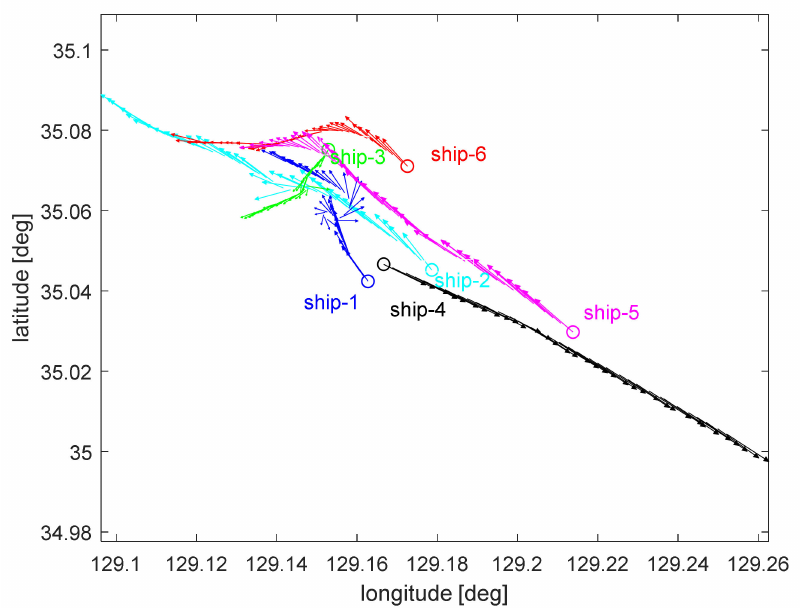
Figure 2. Ship tracks of ships 1–6 with 3-min vectors in a near-collision situation during time 05:33:05–05:53:35 ( : starting position). (cid:35)